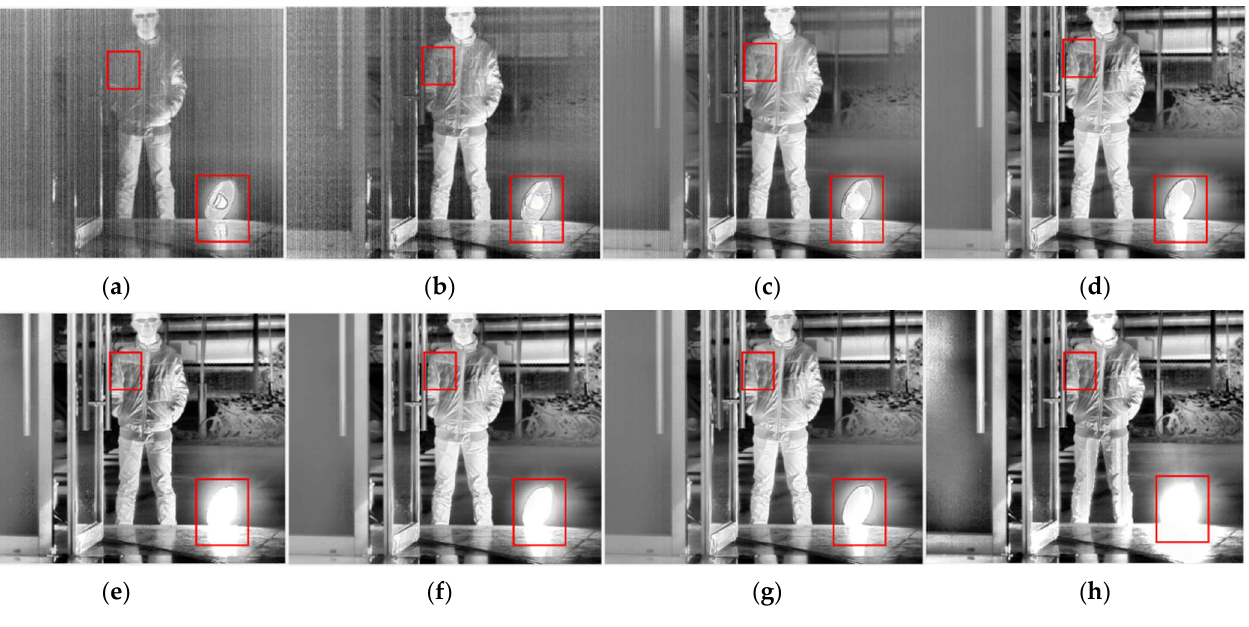
Figure 2. Integration time image sequence plot of high-dynamic-range scene (enhanced effect): ( a ) 13 µ s; ( b ) 67 µ s; ( c ) 133 µ s; ( d ) 332 µ s; ( e ) 665 µ s; ( f ) 1330 µ s; ( g ) 1995 µ s; ( h ) 3990 µ s.